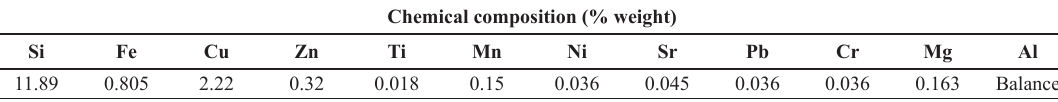
Table 1. Chemical properties of the AlSi13Cu2Fe alloy